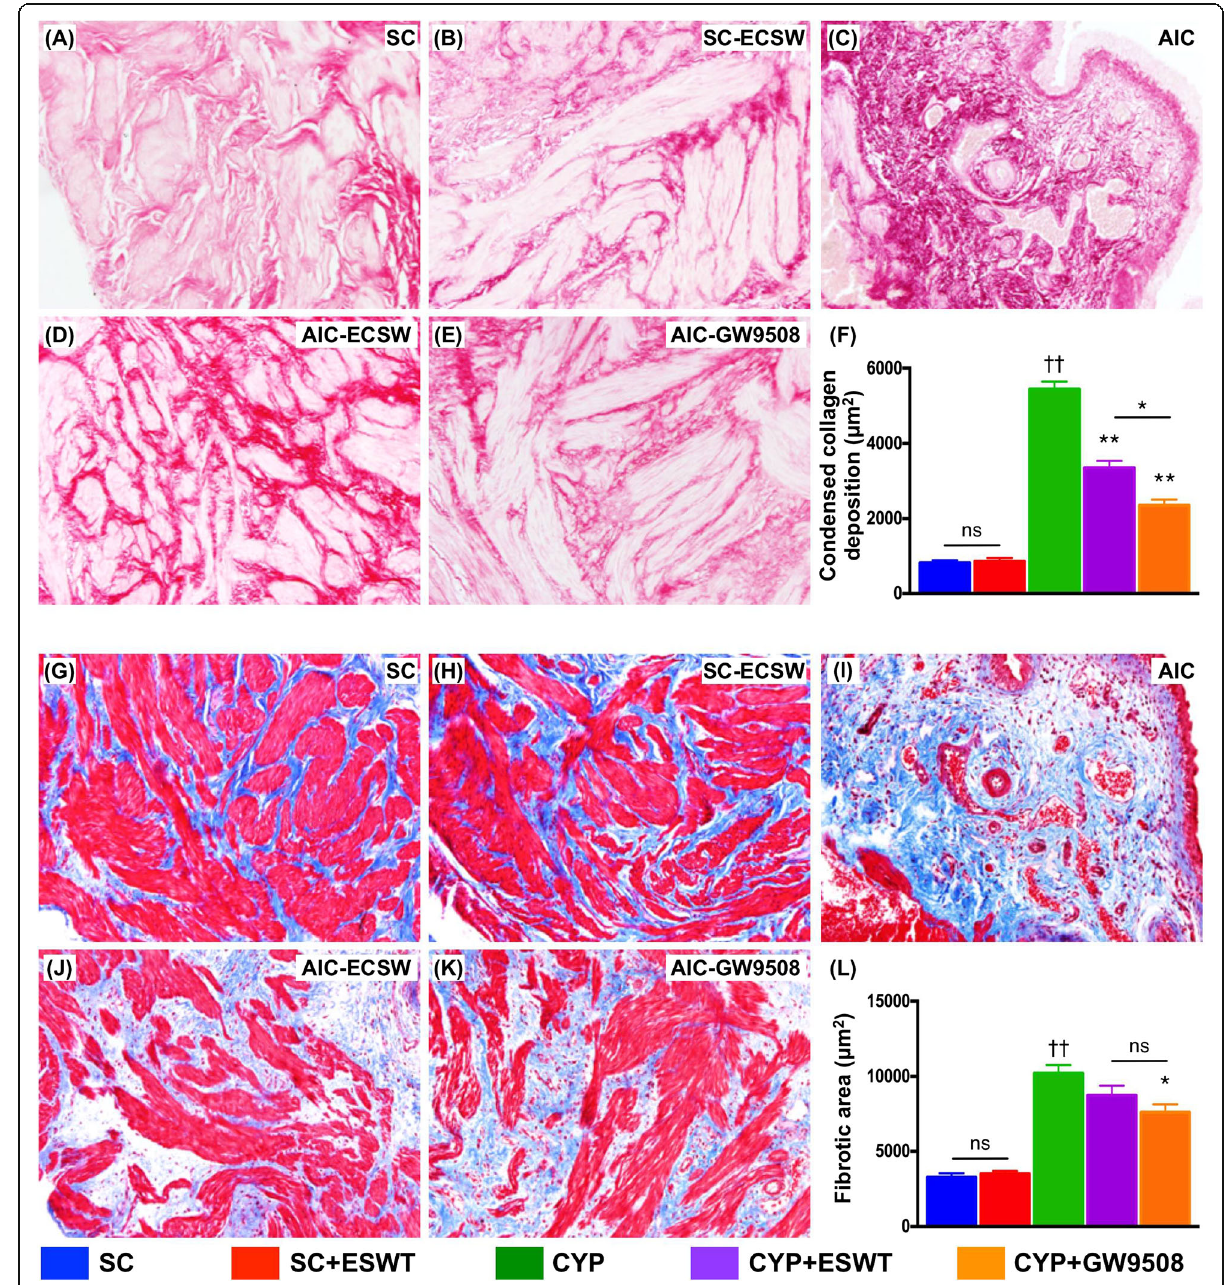
Fig. 7 Fibrosis and condensed collagen deposition in rat urinary bladder following cyclophosphamide (CYP) stimulation with and without GPR120 agonist / extracorporeal shock wave treatment (ESWT). Masson ’ s trichrome and Sirius red-stained bladder sections showing normal urothelium in sham controls with ( a, g ) and without ( b, h ) ESWT. Fibrotic bladder noted in rats following CYP treatment ( c, i ). Significant inhibition of bladder fibrosis after ESWT ( d, j ) and GPR120 agonist (i.e., GW9508) ( e, k ) treatment. f, l Summary of differences in bladder fibrotic area in the five groups of animals ( n = 6 per group). Values expressed as the mean ± SEM. * p < 0.05, ** p < 0.01 vs. CYP; †† p < 0.01 vs. controls; ns, non-significance. Significance of differences determined by one-way ANOVA followed by Bonferroni ’ s post-hoc comparisons tests. Scale bars in right lower corner represent 50 μ m. SC = sham control; CYP = cyclophosphamide; ESWT = extracorporeal shock wave treatment; GW9508= GPR120